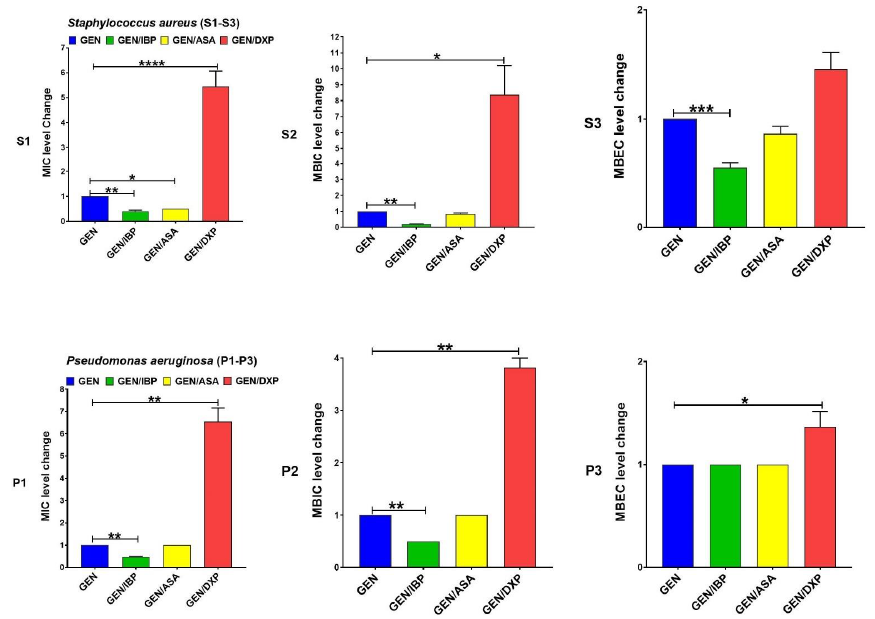
Figure 2. Effects of sub-MICs of ibuprofen (IBP: 200 µg/mL), aspirin (ASA: 200 µg/mL), and dexamethasone sodium phosphate (DXP: 500 µg/mL) on the level of MIC, MBIC, and MBEC of gentamicin (GEN) for clinical isolates. Graphs were drawn based on fold changes of MIC, MBIC, and MBEC for GEN in combination with sub-MICs of IBP, ASA, and DXP on clinical isolates. Data are displayed as the mean ± standard error of the mean from 3 replicate experiments and were analyzed using ANOVA and nonparametric Kruskal – Wallis test. See S1 – S3 for S. aureus and P1 – P3 for P. aeruginosa. IBP significantly decreased the levels of MIC, MBIC, and MBEC for GEN among clinical isolate S. aureus and MIC and MBIC among P. aeruginosa isolates. ASA only significantly decreased MIC for GEN among clinical isolate S. aureus . DXP significantly increased the level of MIC and MBIC for GEN among both clinical isolates and MBEC among P. aeruginosa isolates. *, statistical significance with p ≤ 0.05; **, statistical significance with p ≤ 0.01; ***, statistical significance with p ≤ 0.001; and ****, statistical significance with p ≤ 0.00 01.